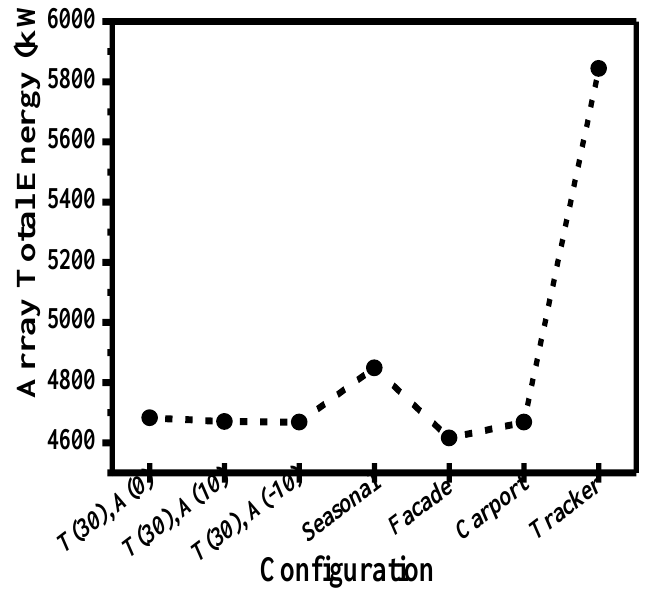
Figure 11: Total energy generated by the array throughout a year for some chosen configurations used in this